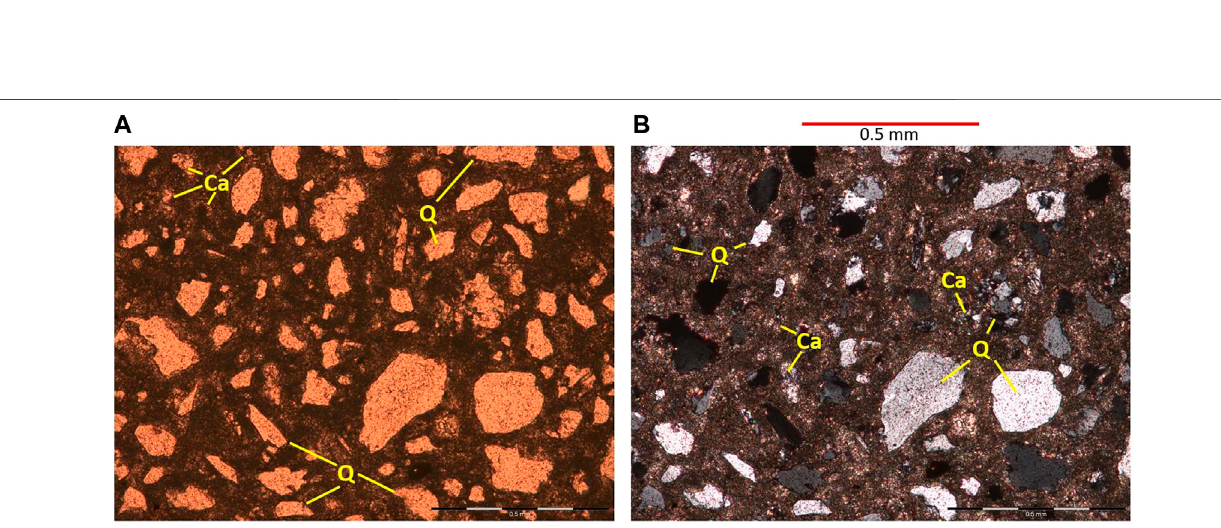
Frontiers in Energy Research |